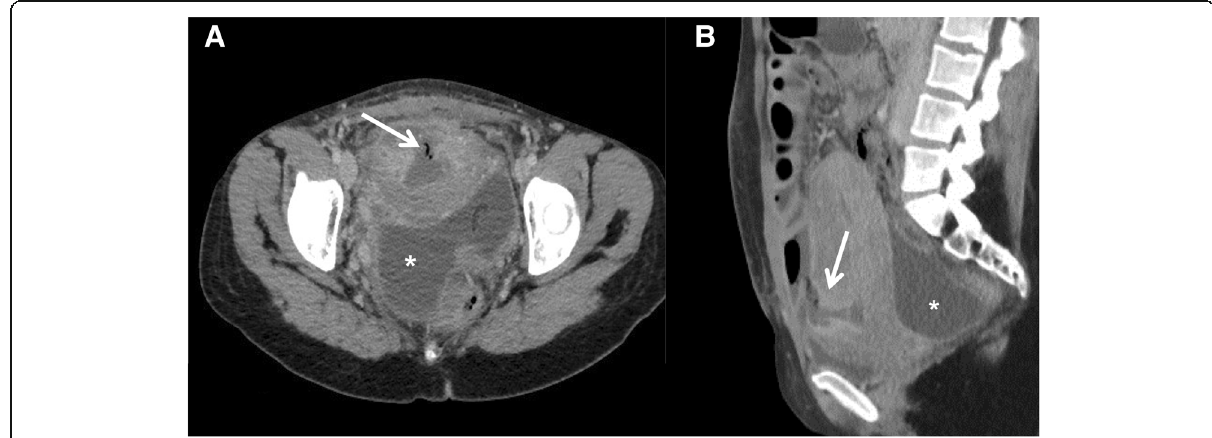
Fig. 5 Uterine rupture : CT examination ( a , b ) showed the presence of gas within the uterine defect, extending from the endometrial cavity to the extra uterine parametrium (white arrow), in association with hemoperitoneum (asterisks). In the appropriate clinical setting, these features are highly suspicious for uterine